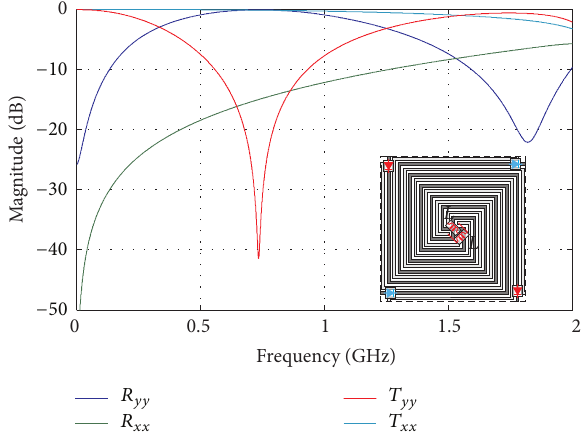
Figure 10: Transmittance and reflectance at normal incidence of the AFSS with the unit cell of Figure 8 illuminated by two orthogonal polarizations when a pair of ideal pin diode switches (depicted in red) are in the on state and the other pair (depicted in blue) is in the off